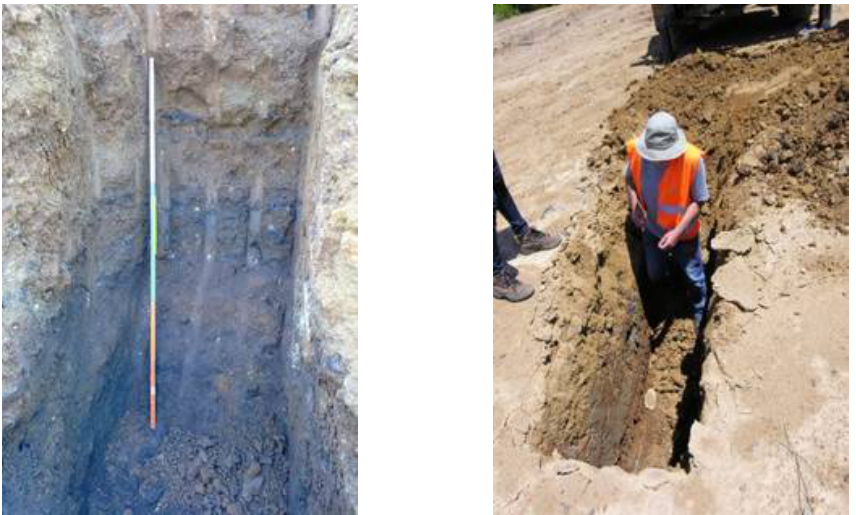
Figure 4. Indicative trenches at the old arsenopyrites concentrate storage area (former the METBA plot) before remediation. Table 2. Acid generation potential. Acid Base Accounting (ABA) tests for the soil samples from the old arsenopyrites concentrate storage area (former METBA plot) before remediation. Parameter.